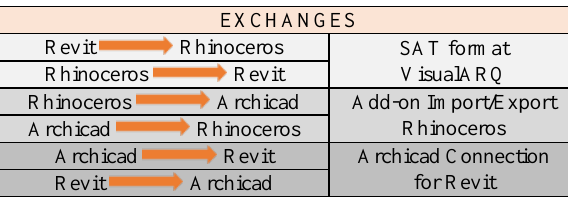
Table 2. The tested exchanges (on the left) and the equivalent means to run those exchanges (on the right).